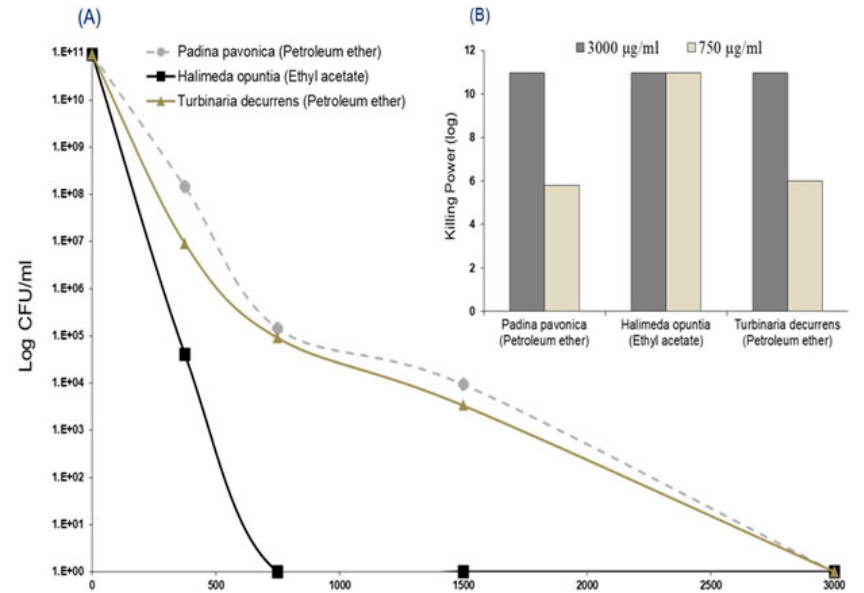
Fig. 4. Anticandidal activity of three algae extracts (log CFU/ml); P. pavonica, H. opuntia and T. decurrens , against Candida tropicalis were shown in Fig. 4A. The Killing powers of two concentrations (3000 and 750 µg/ml) per each extract against the C. tropicalis were shown in Fig. 4B. The assays were performed in triplicate (n =